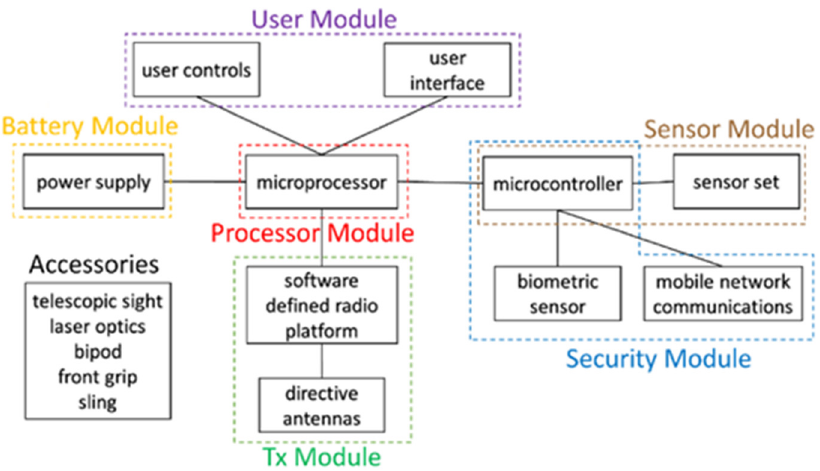
Figure 1. System architecture.